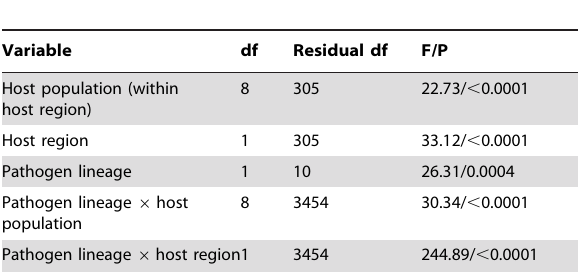
Table 1. Results of GLMMs on the effects of host origin and pathogen lineage on resistance responses at the regional